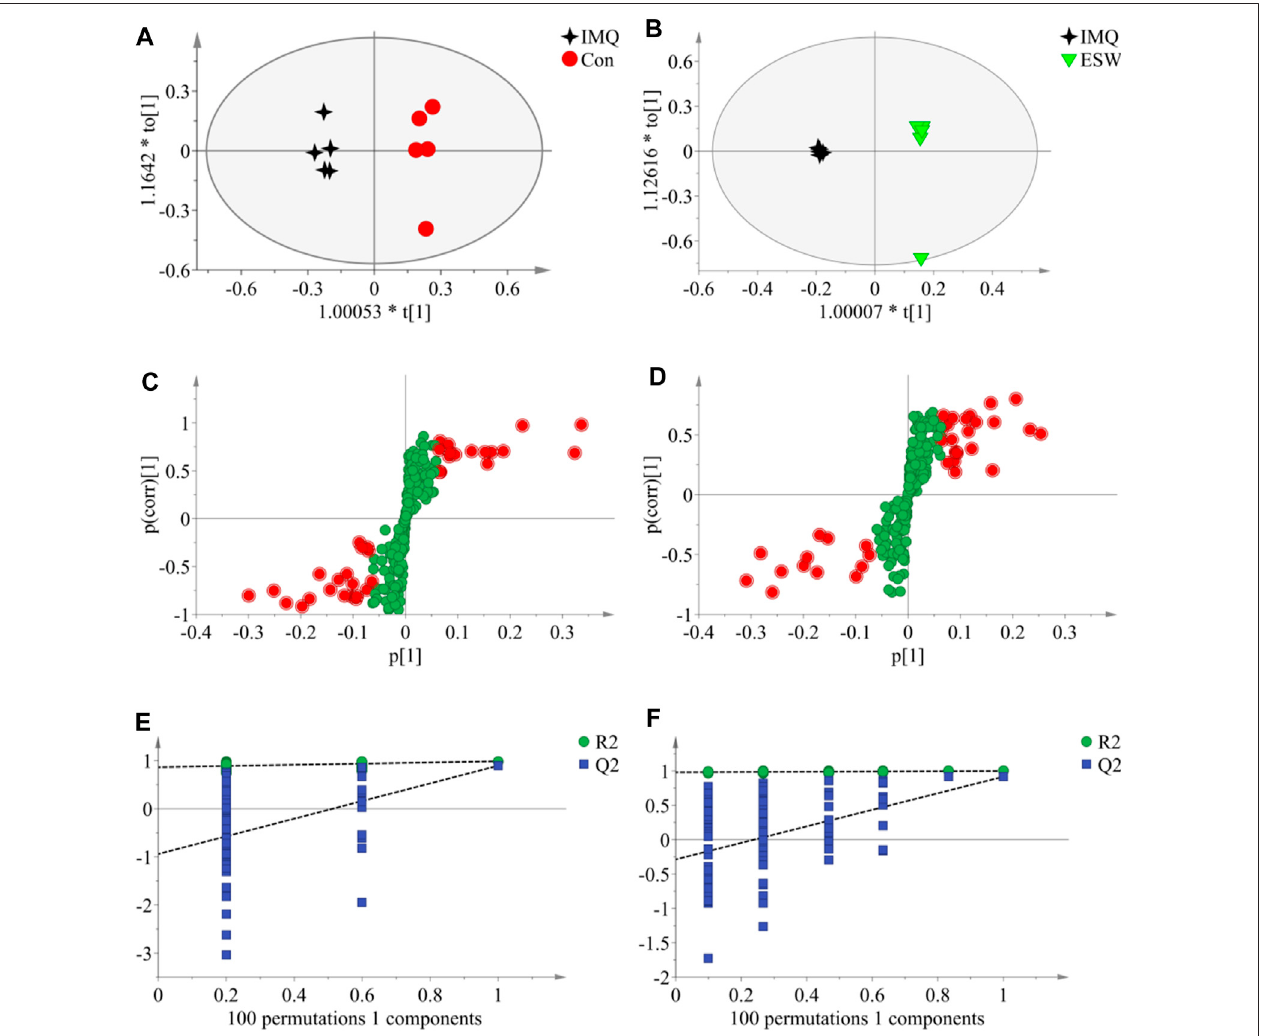
FIGURE 6 | The OPLS-DA data of the spleen tissue. (A , B) OPLS-DA score plots comparisons between the Con and IMQ groups as well as the IMQ and ESW groups, respectively. (C , D) S-plots oftheOPLS-DAmodelfortheConandIMQgroupsaswellasfortheIMQandESWgroups,respectively. (E , F) The100-permutation test of the OPLS-DA model was for the Con and IMQ groups as well as for the IMQ and ESW groups, respectively.